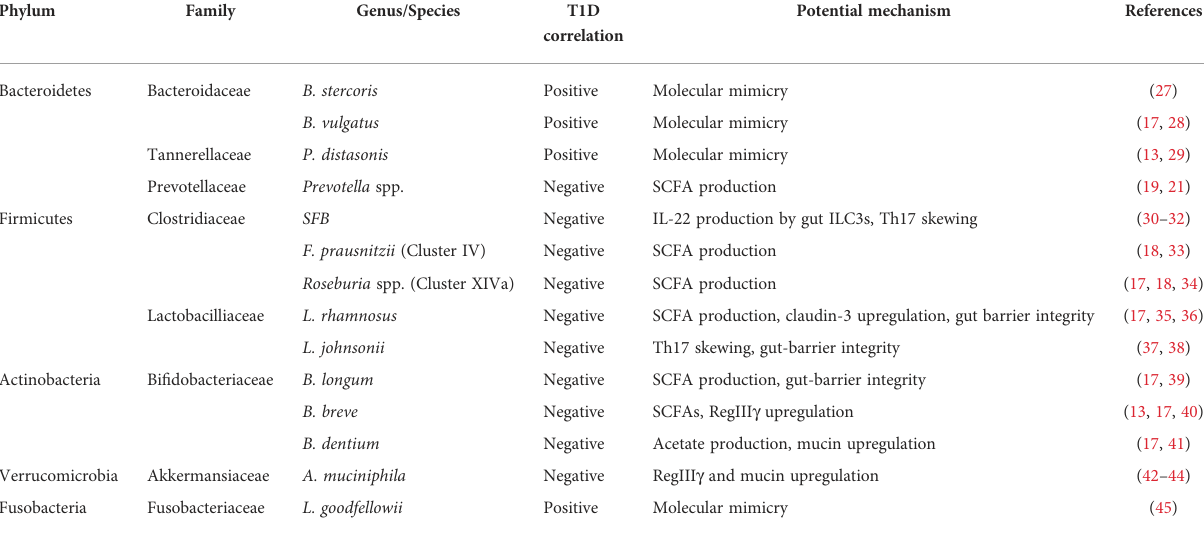
TABLE 1 Association of Gut Commensal Bacteria with T1D incidence and proposed mechanisms.